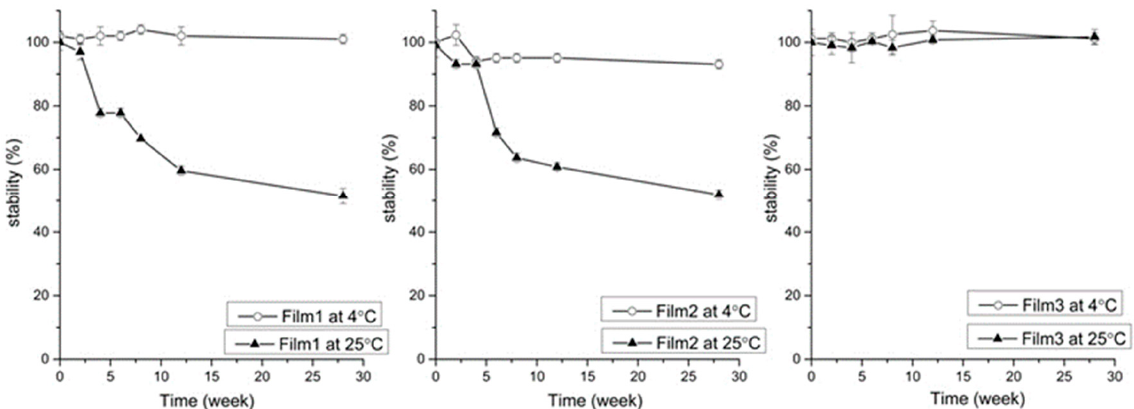
Figure 7. Stability of doxycycline in buccal films at 4 and 25 ◦ C. Film 1 = contained doxycycline in chitosan, gelatin, povidone, glycerin and Eudragit ® RS 12.5; Film 2 = contained doxycycline, β -cyclodextrin and HPMC microparticles in chitosan, gelatin, povidone, glycerin and Eudragit ® RS 12.5; and Film 3 = same as in Film 2, but the manufacturing of microparticles was performed using sodium thiosulfate, MgCl 2 in 2% HPMC with Eudragit ® RS